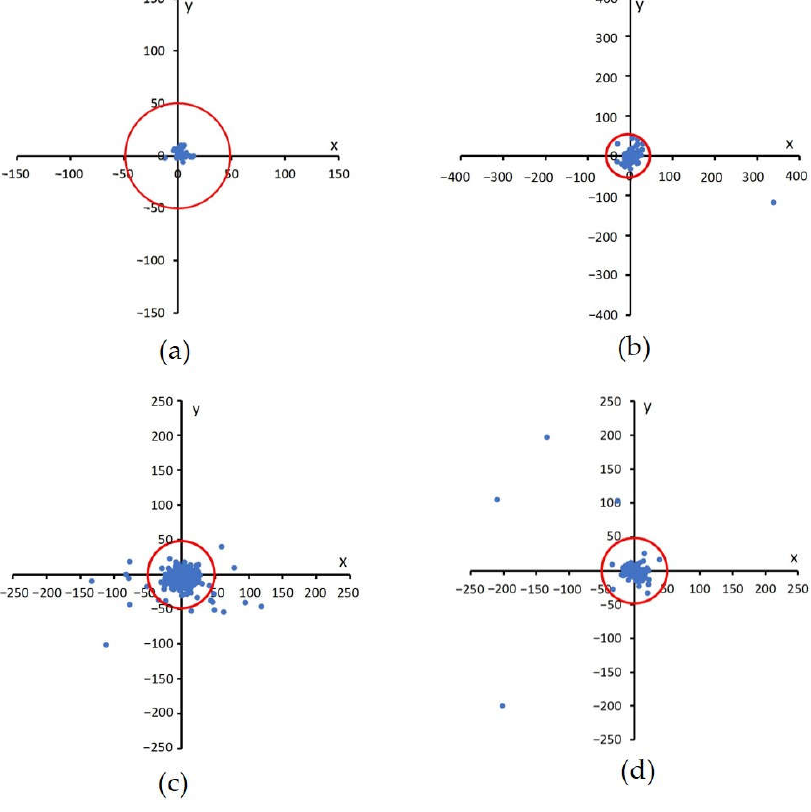
Figure 8. Euclidian distance distribution between the proposed method with GT. A red circle with a radius of 50 shows the acceptable distance limit for well-detected results, ( a ) DRIVE, ( b ) DiaretDB1, ( c ) Messidor, and ( d ) JOGED.com (accessed on 22 July 2022).